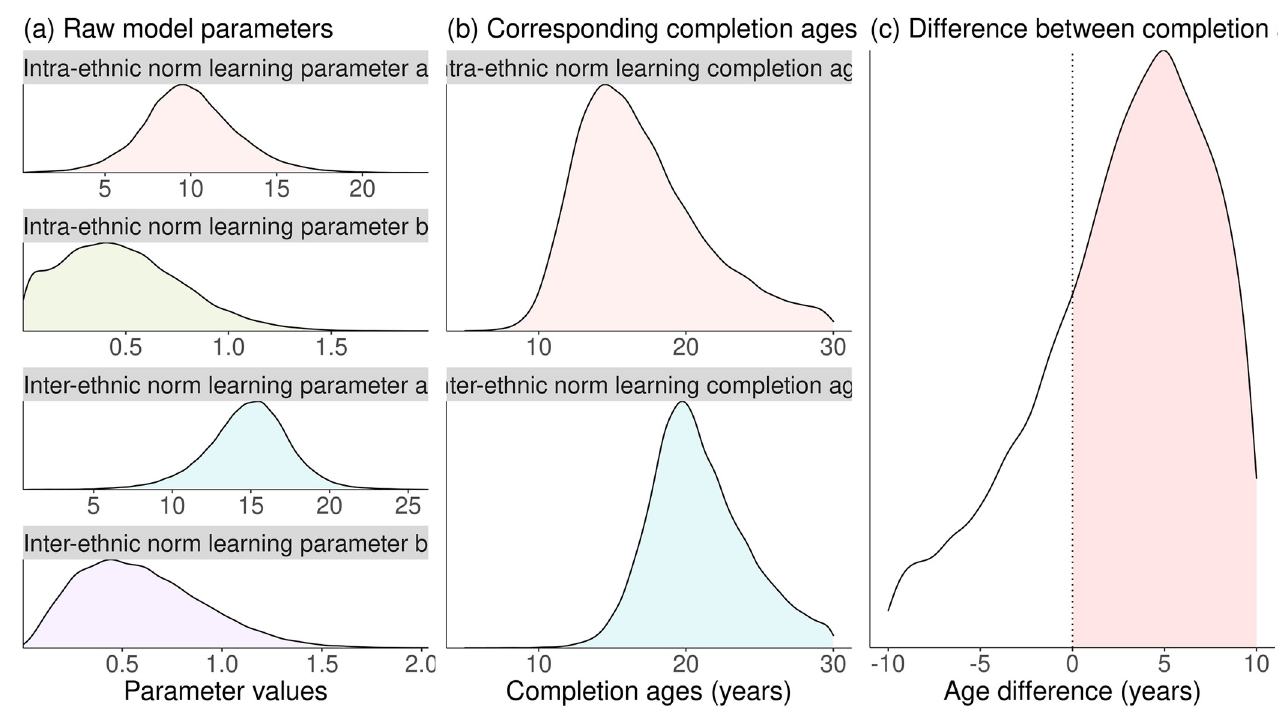
Fig 4. Visualization of our interpretation of the fitted model for a single society. The leftmost panel (a) shows the posterior distributions for the four separate model parameters, neither of which bares directly on our hypothesis. Each pair of posteriors for the a and b parameters determines a posterior distribution for the age at which acquisition of a particular norm is completed, as shown in the centre panel (b). This pair of distributions in turn defines a posterior distribution over the difference in completion ages. This distribution is shown in the rightmost panel (c), computed by subtracting the inter-ethnic completion age from the intra-ethnic completion age, such that positive values are consistent with our hypothesis that intra-ethnic norms are acquired earlier. The red-shaded area in panel (c) represents the posterior probability that our hypothesis is correct.